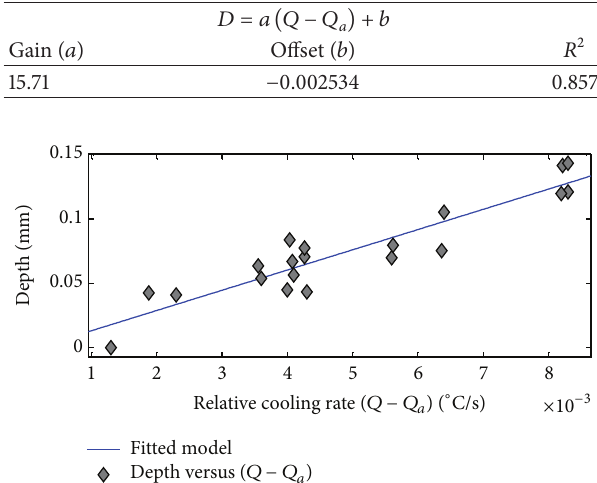
than the number of pixels on the cooling rate image. For